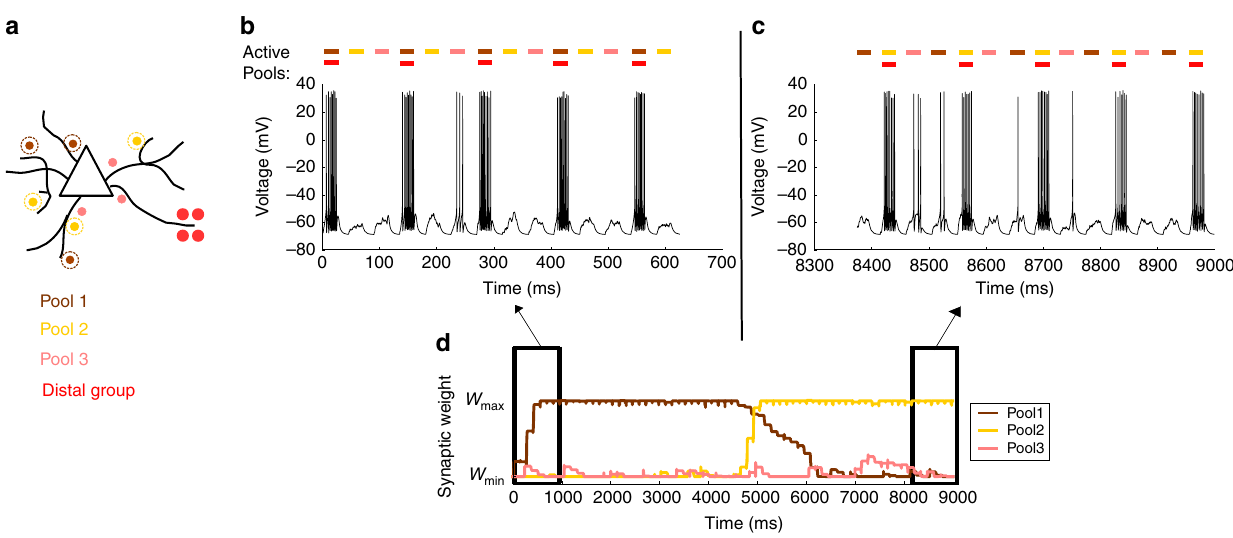
Fig. 4 Distally evoked plateau potentials can switch the direction of plasticity at other synapses. a Different groups of synapses are connected to the neuron: three pools ( brown , yellow , pink ) are randomly distributed across the basal dendrites, and one group ( red ) is connected on one distal compartment. b The distal cluster ( red ) is paired with pool 1 ( brown ) in the fi rst half of the simulation. The neuron almost exclusively reaches the spiking threshold when these synapses are active together. This leads to potentiation of the brown synapses ( d , fi rst part ). c The distal cluster ( red ) is paired with pool 2 ( yellow ) in the second part of the simulation. The brown synapses depress again and the yellow synapses are potentiated ( d , second part ). As the distal ( red ) group evokes an NMDA spike every time it is activated, it remains at the maximum